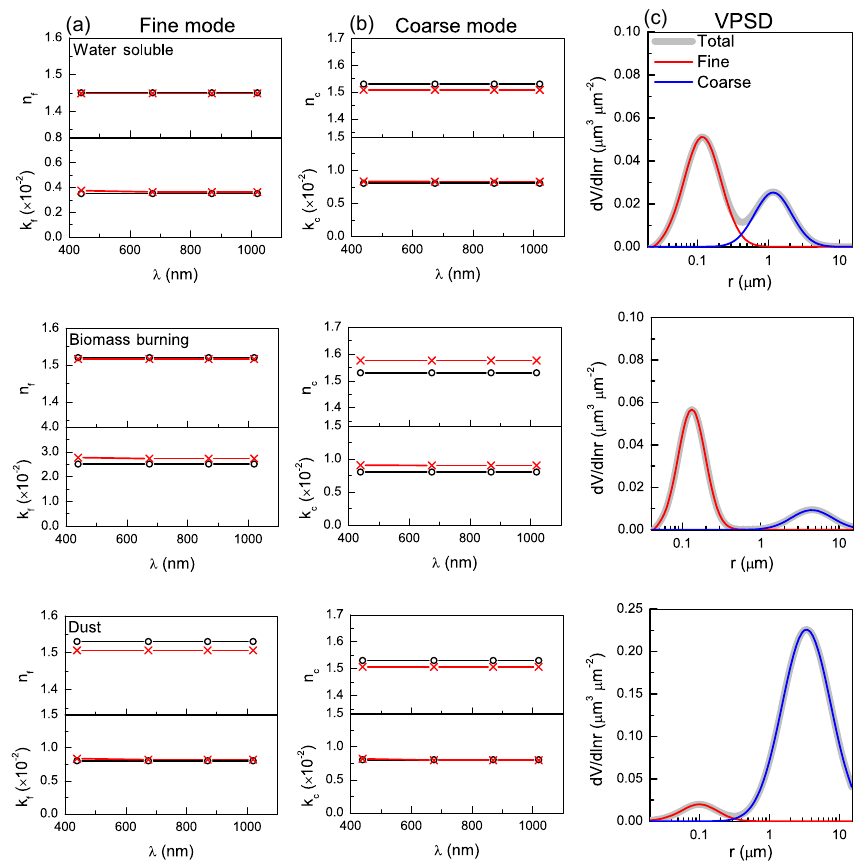
Figure 3. Estimation of complex refractive indices for both fine (a) and coarse (b) modes of three aerosol types (each row). True values are in circles and retrieved values are in cross symbols. The volume particle size distributions and corresponding breakdown results (c) are also shown.